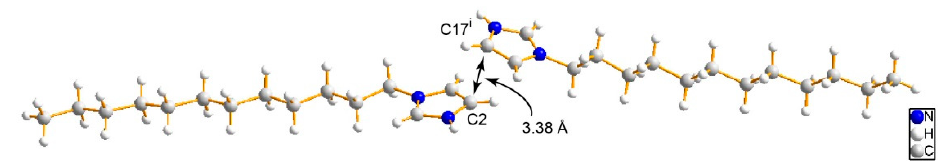
Figure 5. View of crystallographically independent C 12 im cations. Symmetry code: ( i ) − x , − 0.5 + y , 0.5 − z .